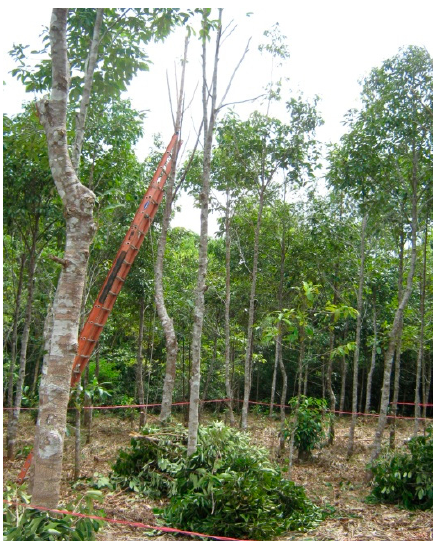
Figure A13. 100% canopy pruning and canopy climbing ladder for removal of branches and leaves.